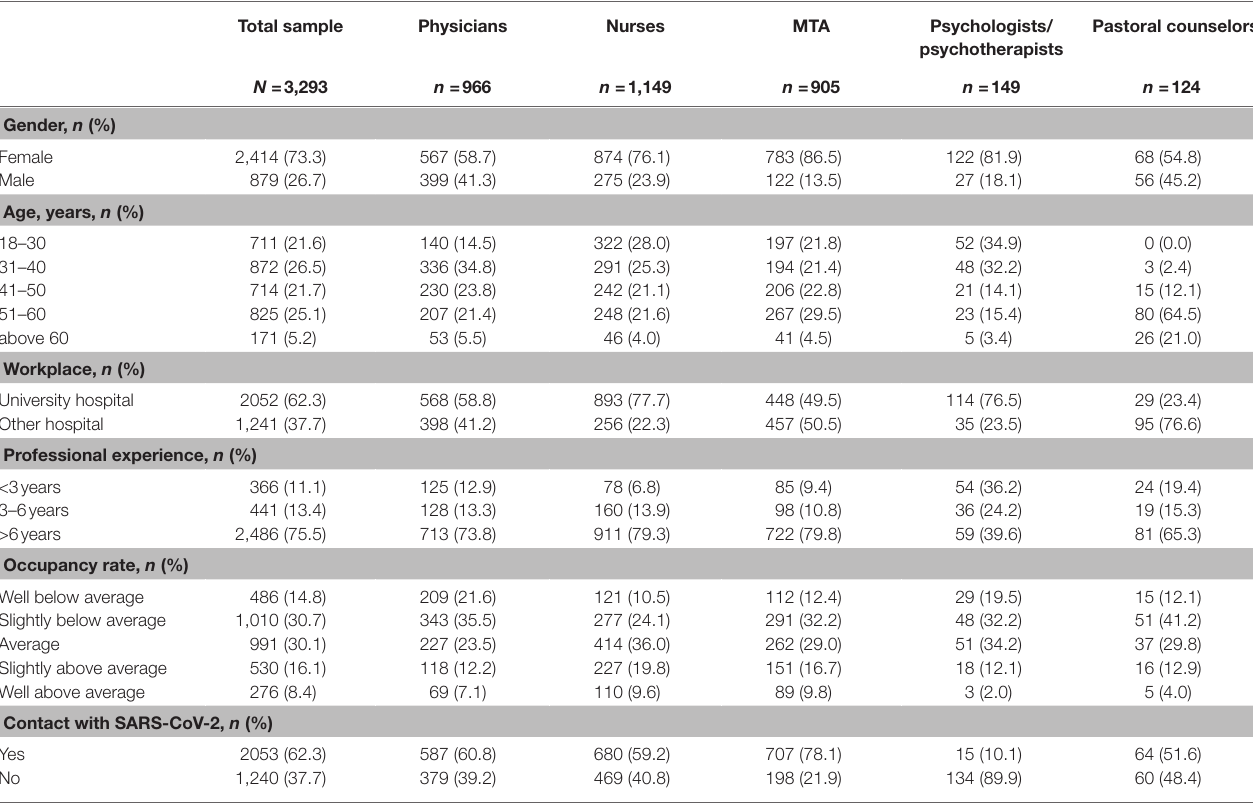
TABLE 1 | Characteristics of the study